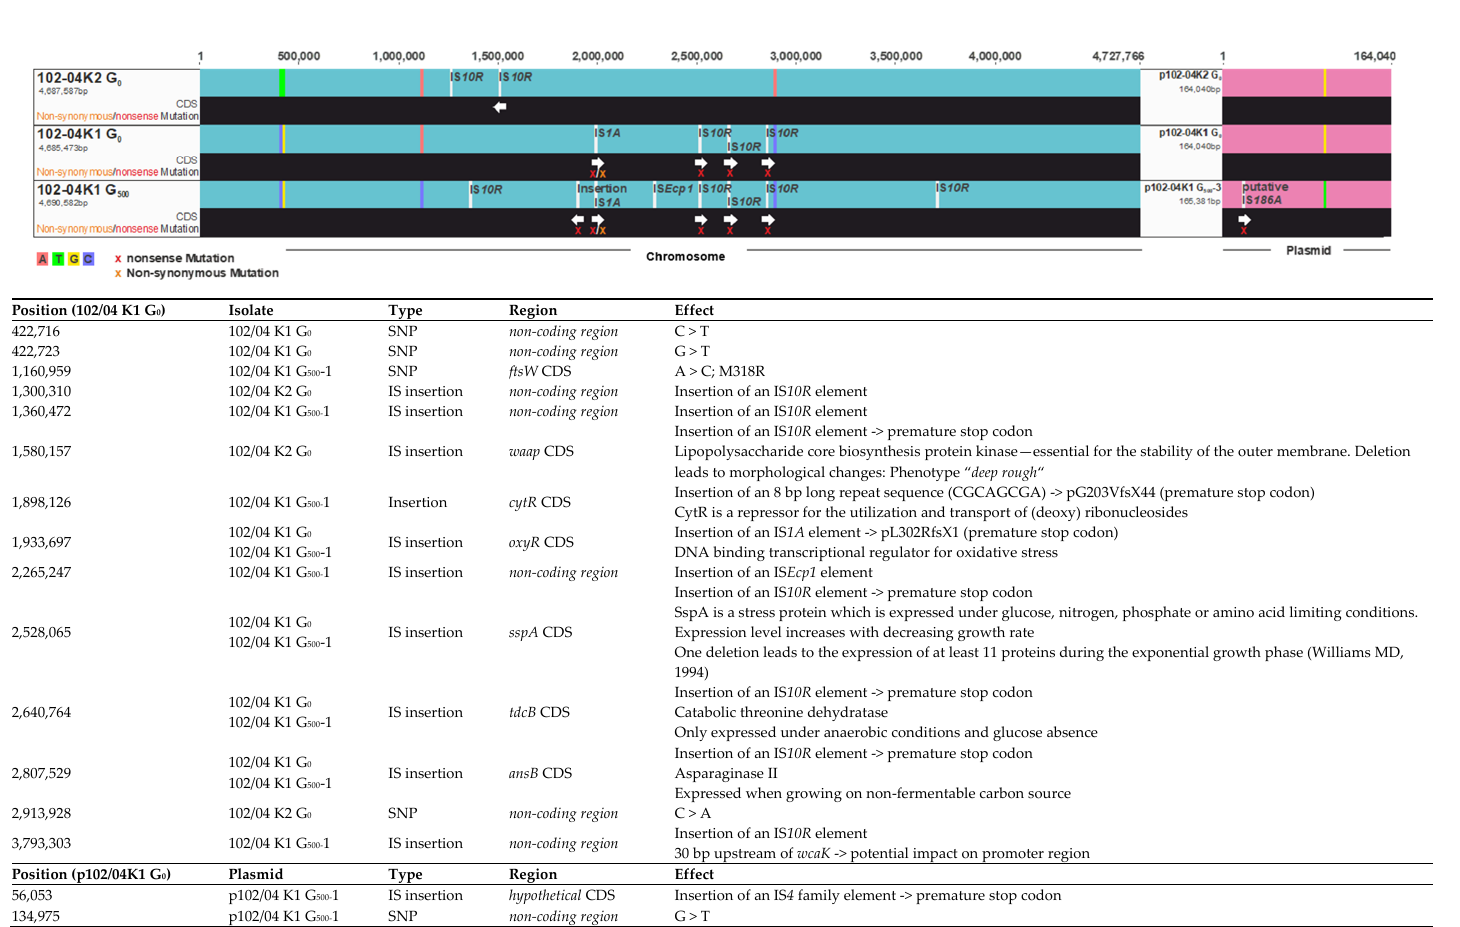
Figure 3. Schematic presentation of the genetic changes of transconjugant isolates 102/04 K1 und K2 after long-term growth. Mutations in the chromosomes and amino acid changes are marked at the respective positions. Base pair substitutions are marked by color. Positions of modified IS elements are highlighted by white bars. White arrows point towards changes in coding